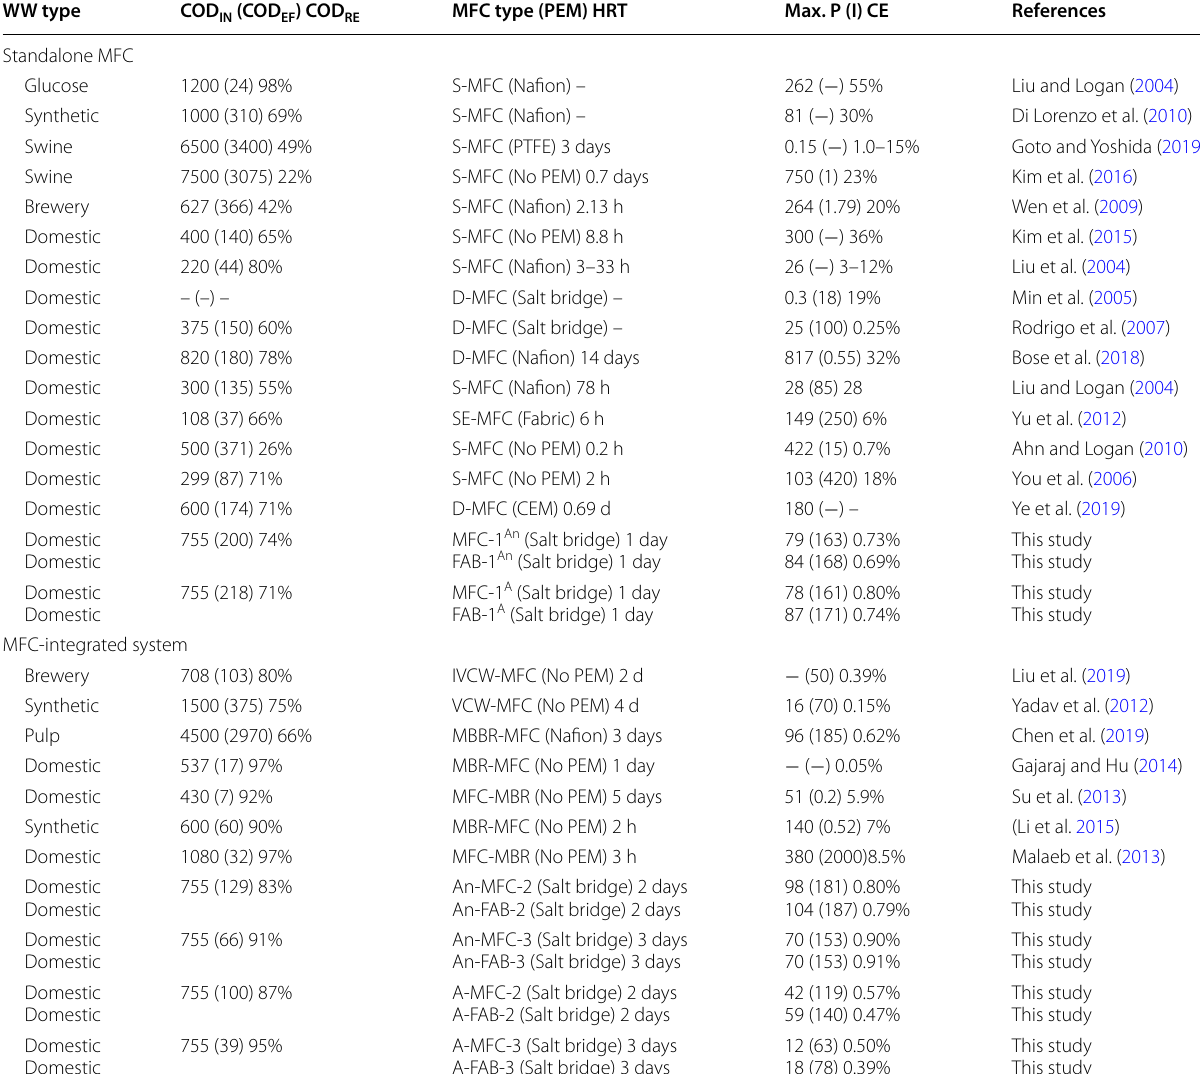
Table 2 Comparisons of FAB–MFC integrated system with other